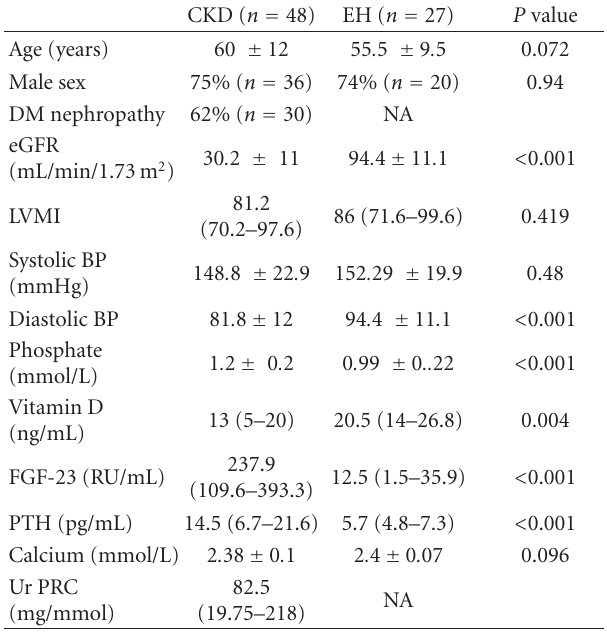
Table 1: Comparison of the baseline characteristics between the patients with CKD and control patients with essential hypertension